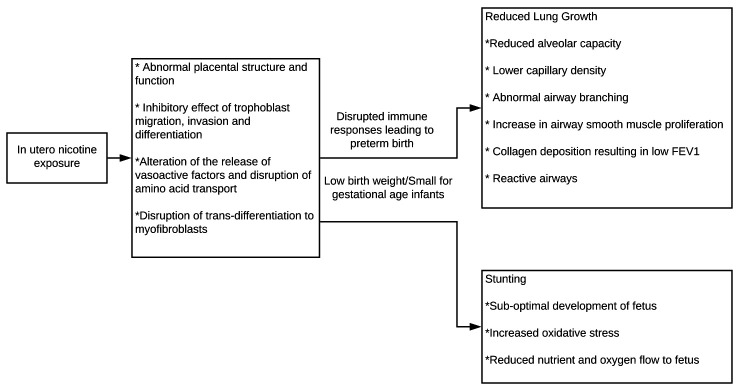

In utero nicotine exposure, RLLF and Stunting
78,
81–
83,
98.